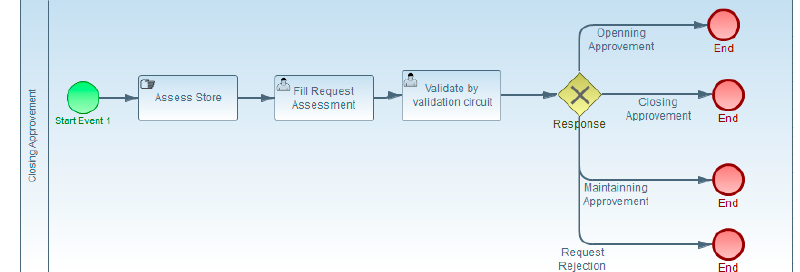
Figure 12. High-level process modeling.